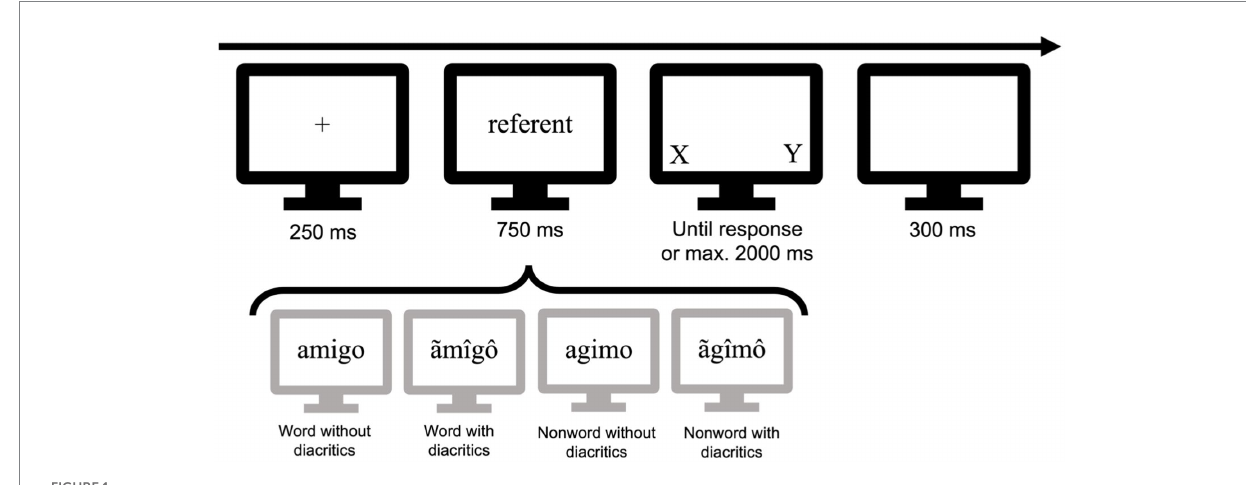
FIGURE 1 Depiction of the procedure and the four conditions used in the experiment.